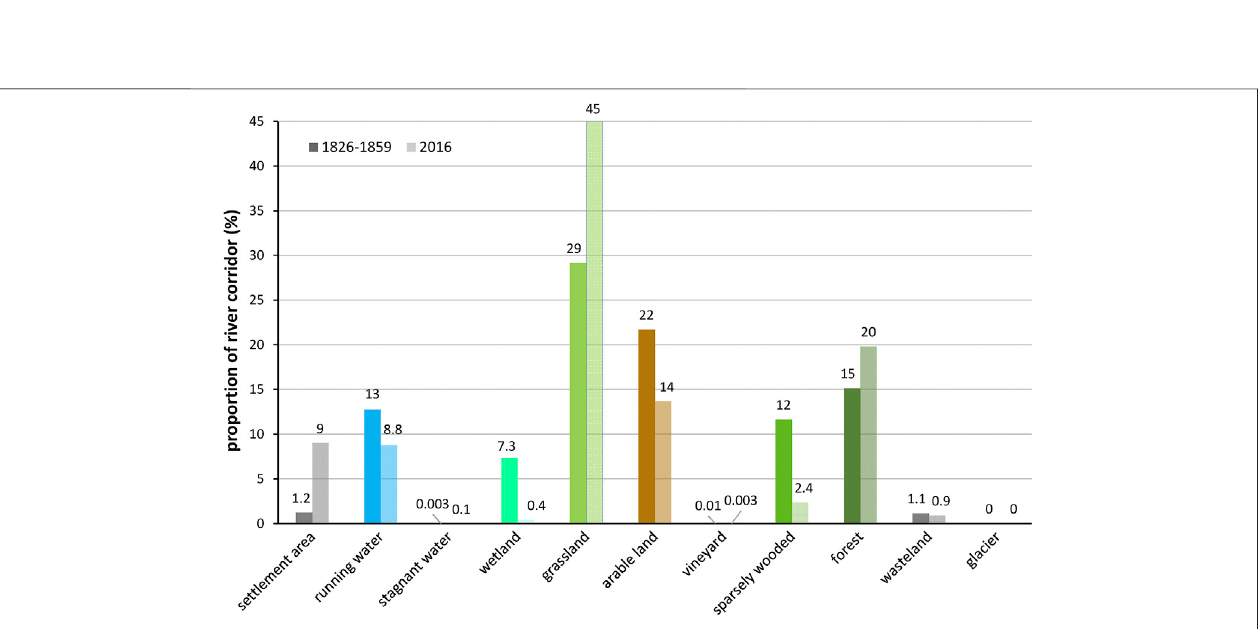
Frontiers in Environmental Science |